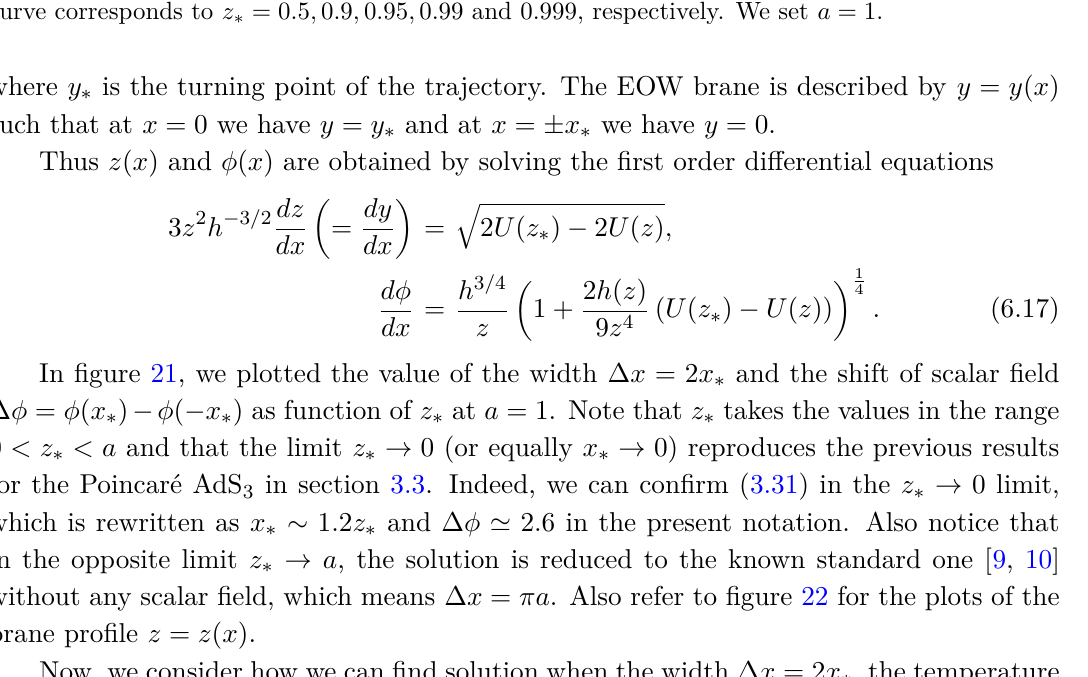
Figure 22 . The profile of the EOW brane in thermal AdS 3 . The blue, yellow, green and purple curve corresponds to z ∗ = 0 . 5 , 0 . 9 , 0 . 95 , 0 . 99 and 0 . 999 , respectively. We set a = 1